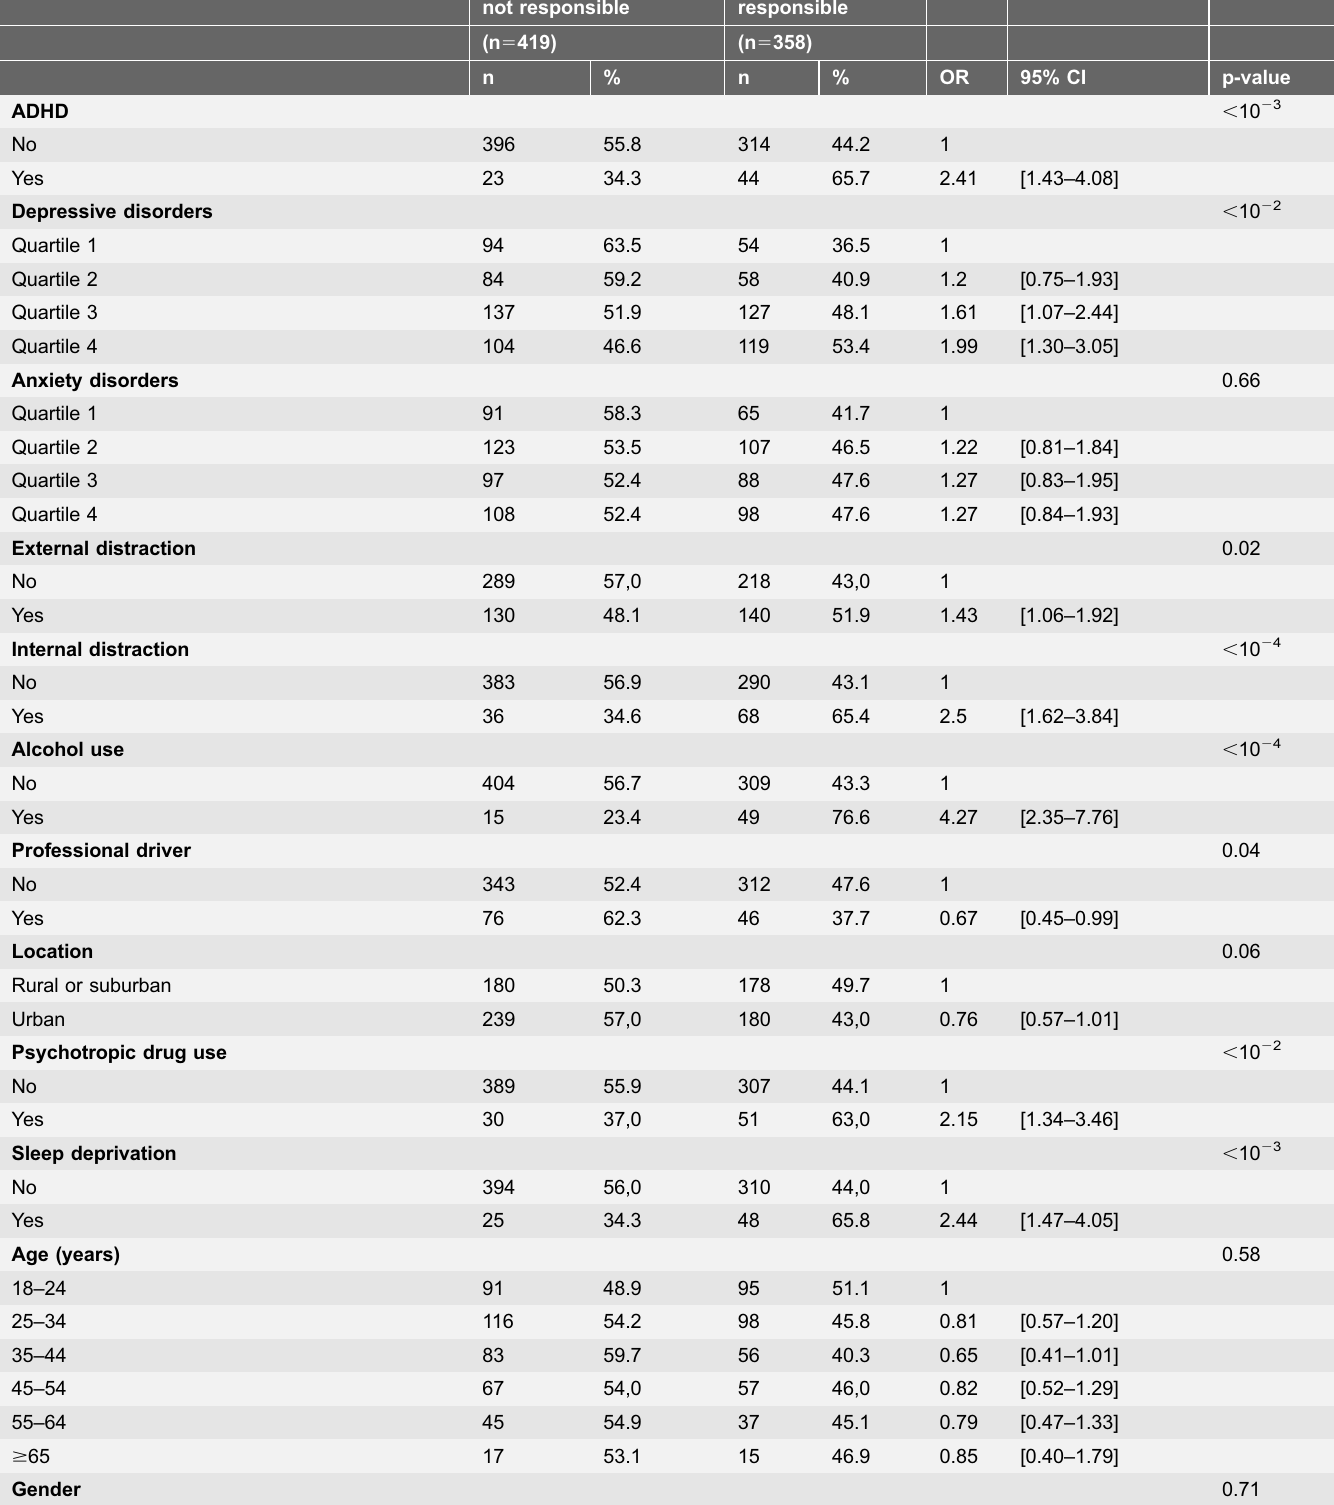
Table 1. Sample characteristics and univariate analysis of driver responsibility for road traffic crashes, univariate logistic regression (n 5 777). not